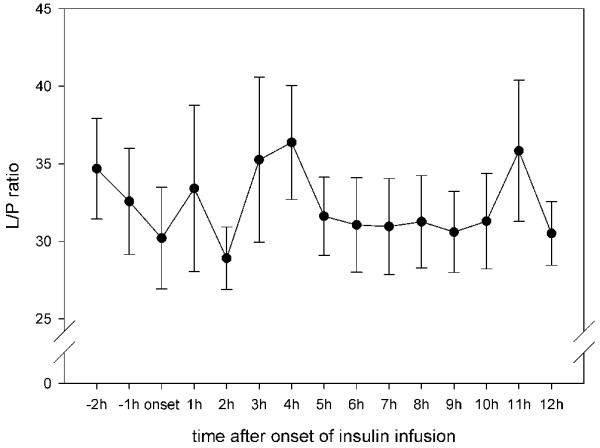
Course of cerebral lactate/pyruvate ratio during insulin infusion. Data are expressed as mean ± standard error of hourly microdialysate levels from 24 patients treated with continuous intravenous insulin. L/P, lactate:pyruvate.